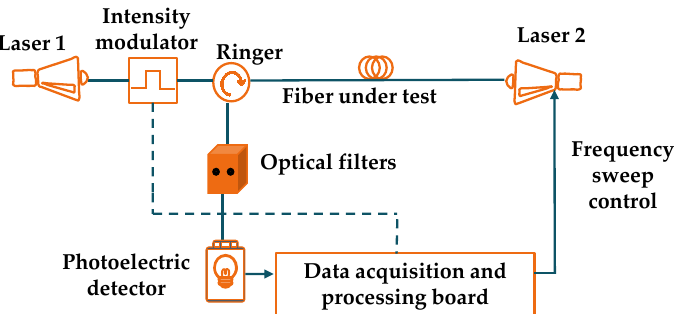
Figure 14. Typical system structure of BOTDA.